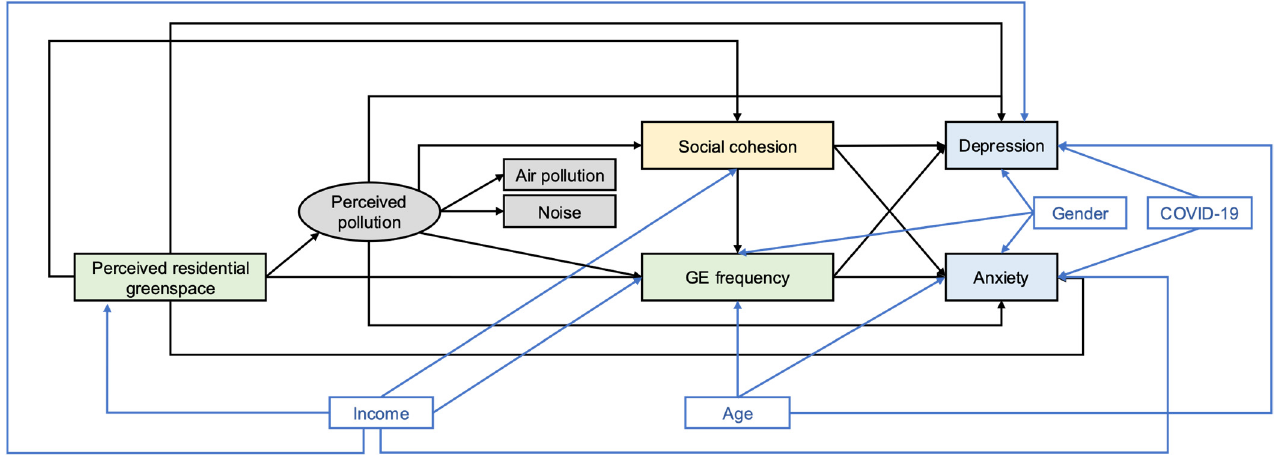
Figure 1. Conceptual framework. Note: GE, green exercise. Black lines indicate pathways between core variables (perceived residential green space, perceived pollution, social cohesion, green exercise frequency, depression, and anxiety). Blue lines indicate confounding pathways between core and control variables (income, age, gender, and COVID-19 condition).